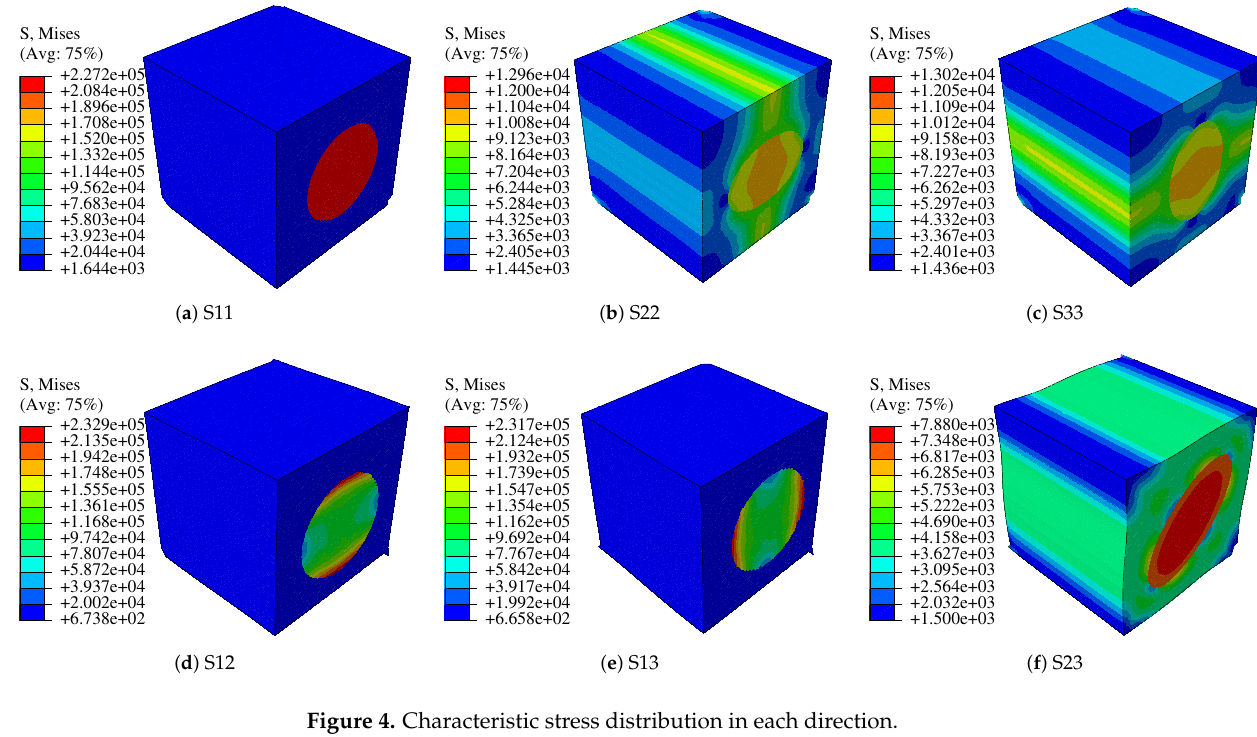
Figure 4. Characteristic stress distribution in each direction.